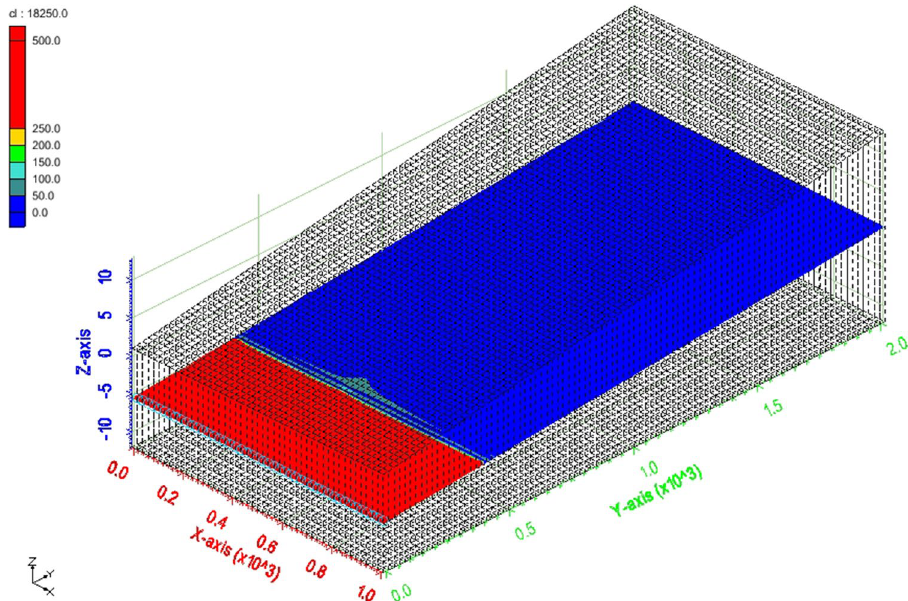
Fig. 3 Results of seawater intrusion after cutoff wall design from 400 m location of